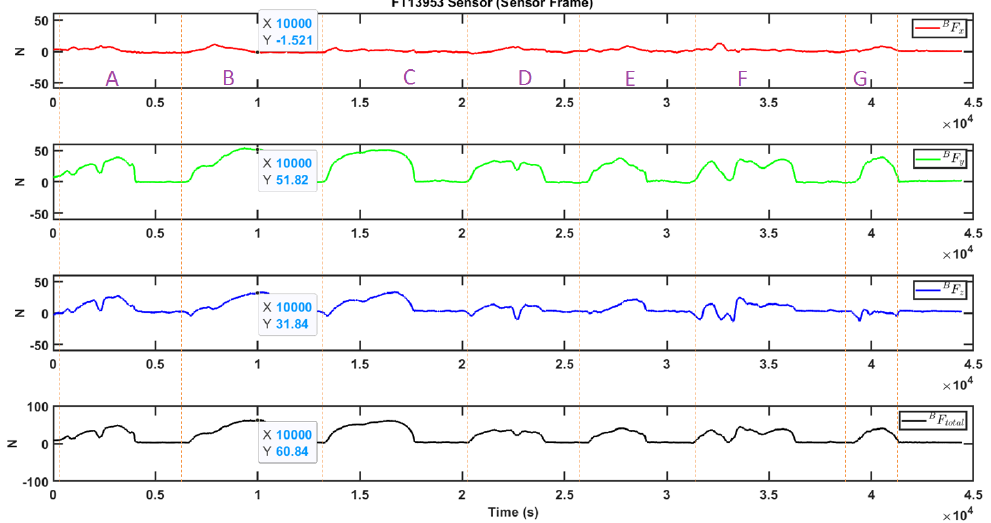
Figure 28. Forces applied by the user in Experiment